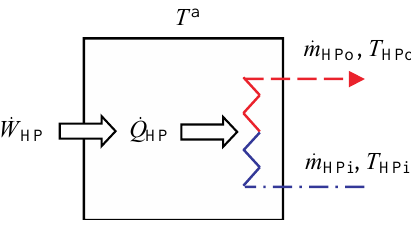
Figure A1. Model for CO 2 heat pump.